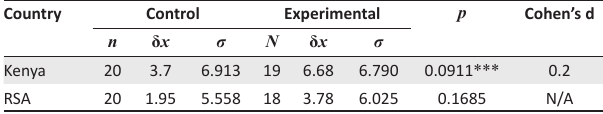
FIGURE 2: Change in mean scores in the comparison and experimental groups in the South African and Kenyan TABLE 4: Comparison of mean score changes between the experimental and control groups in Kenya and South Africa. Country Control Experimental p Cohen’s d